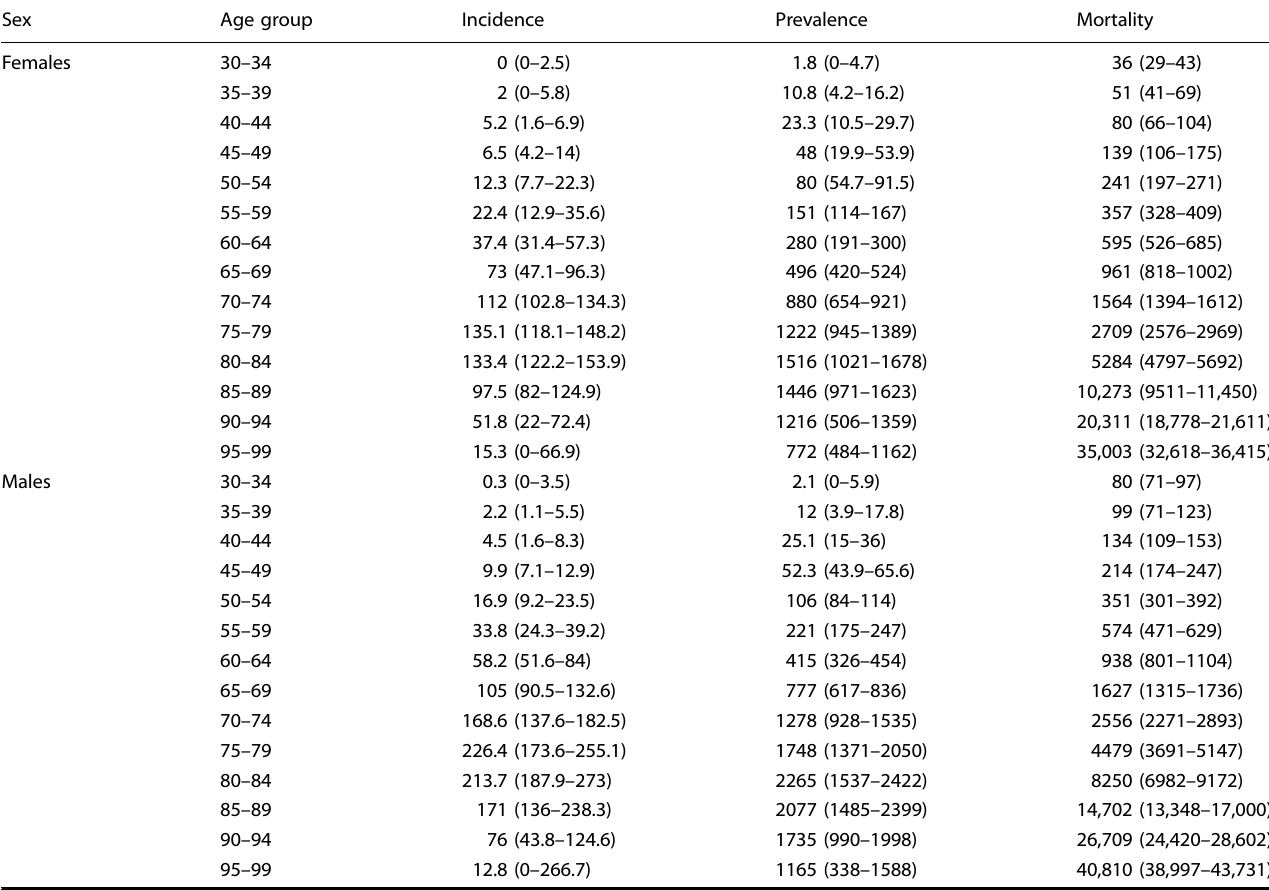
Table 1. Age- and sex-adjusted PD incidence, prevalence, and